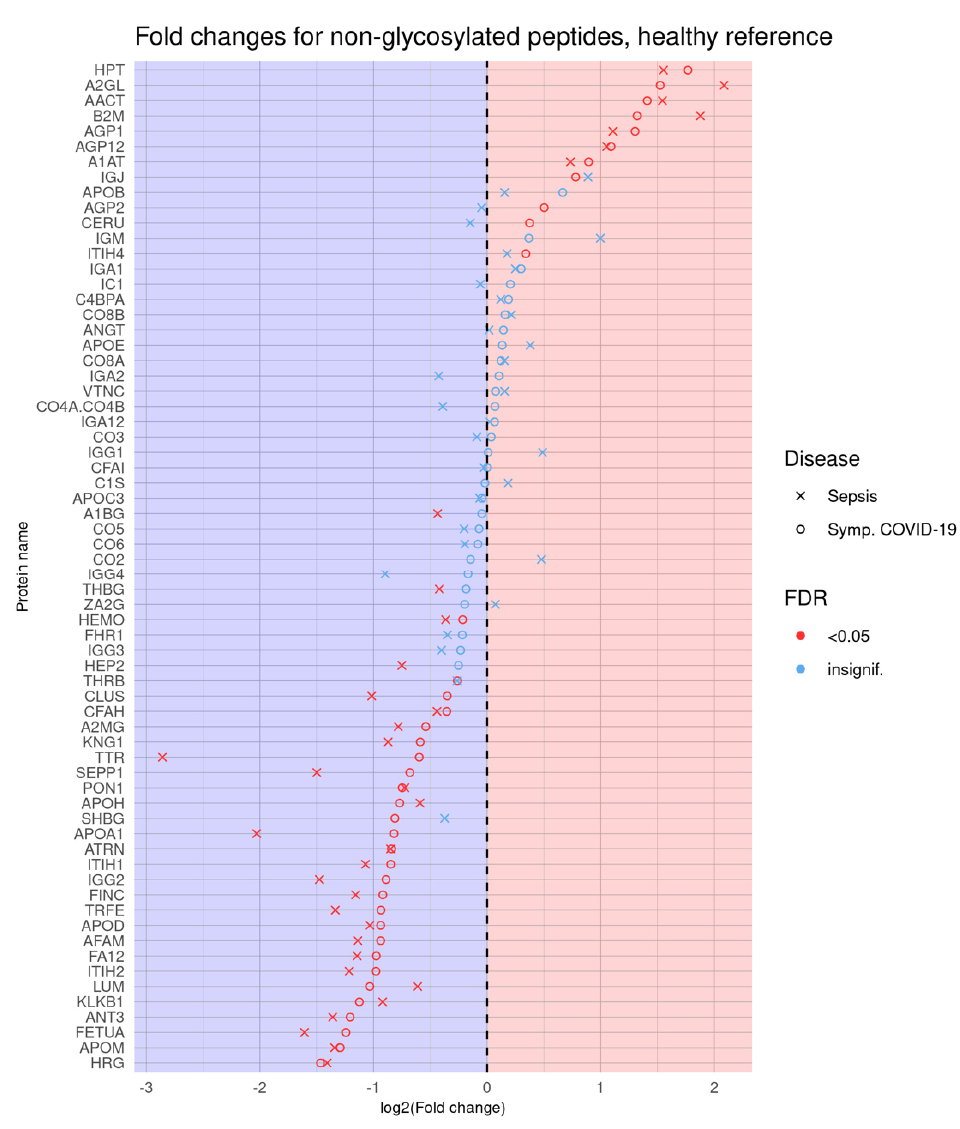
Figure 9. Dot plot showing log-transformed fold changes for each nonglycosylated peptide, using healthy controls as the reference against the sepsis and symptomatic COVID-19 (by which this is sorted) phenotype groups, each indicated using its own symbol. Red symbols represent those that are statistically significant at FDR < 0.05. Table 2. Allocation to predicted clusters based on K-means